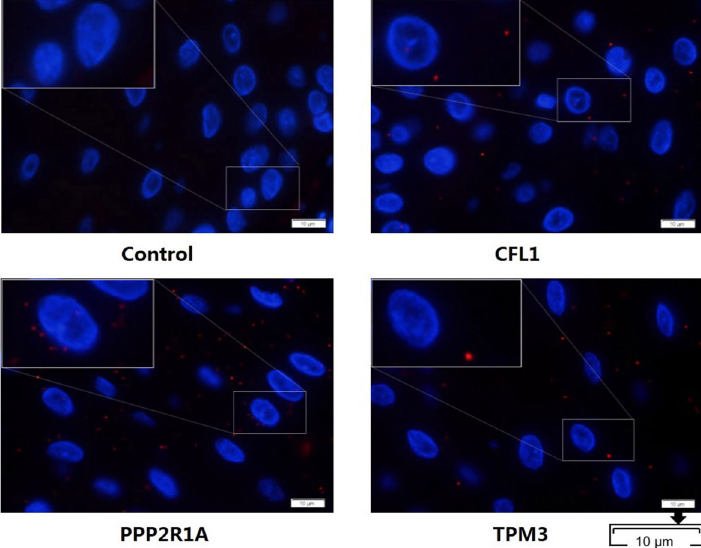
Figure 5. Duolink analysis. The interactions of PPP2R1A, TPM3, and CFL1 with Prx1 in human oral leukoplakia tissues were detected by in situ Duolink analysis. Proximity ligation assay signals are shown in red and the nuclei are stained in blue ( (cid:3) 1000, scale bar 10 m